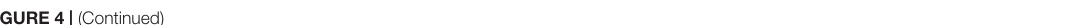
Frontiers in Cell and Developmental Biology |